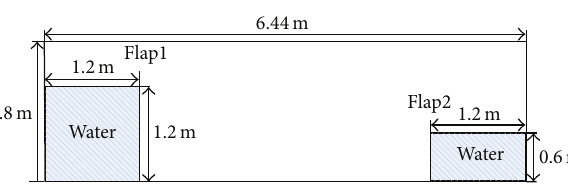
Figure 3: Comparison of the water height ℎ 1 at point A.